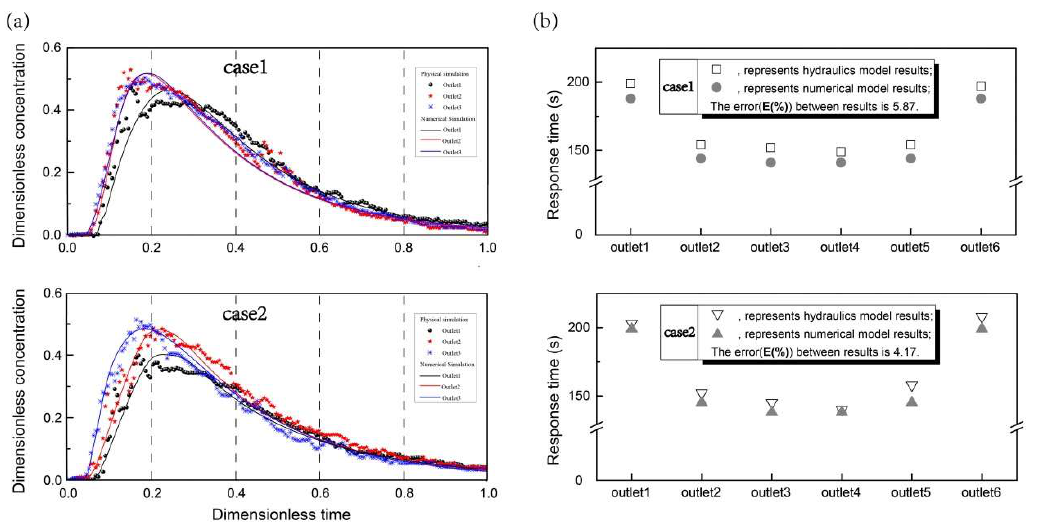
Figure 5. ( a ) RTD curve comparison between hydraulic model and numerical model; ( b ) the response time of case 1 and case 2. Table 4. Main flow field indicators in case 1 and case 2.